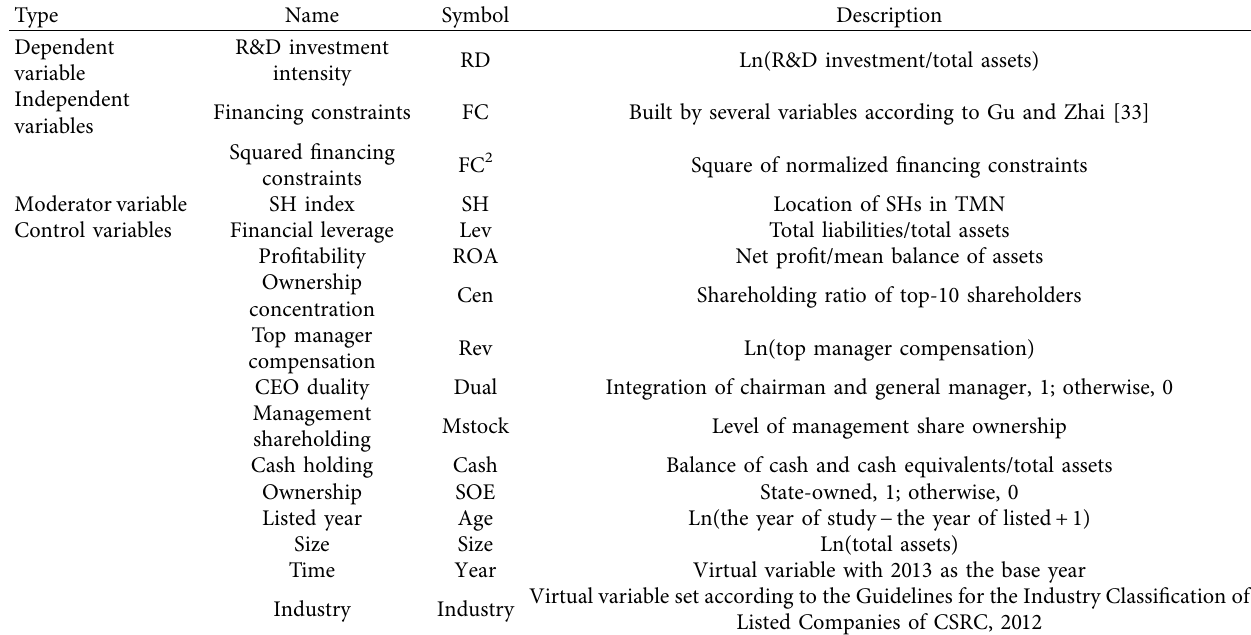
Table 1: Main variables and definitions.